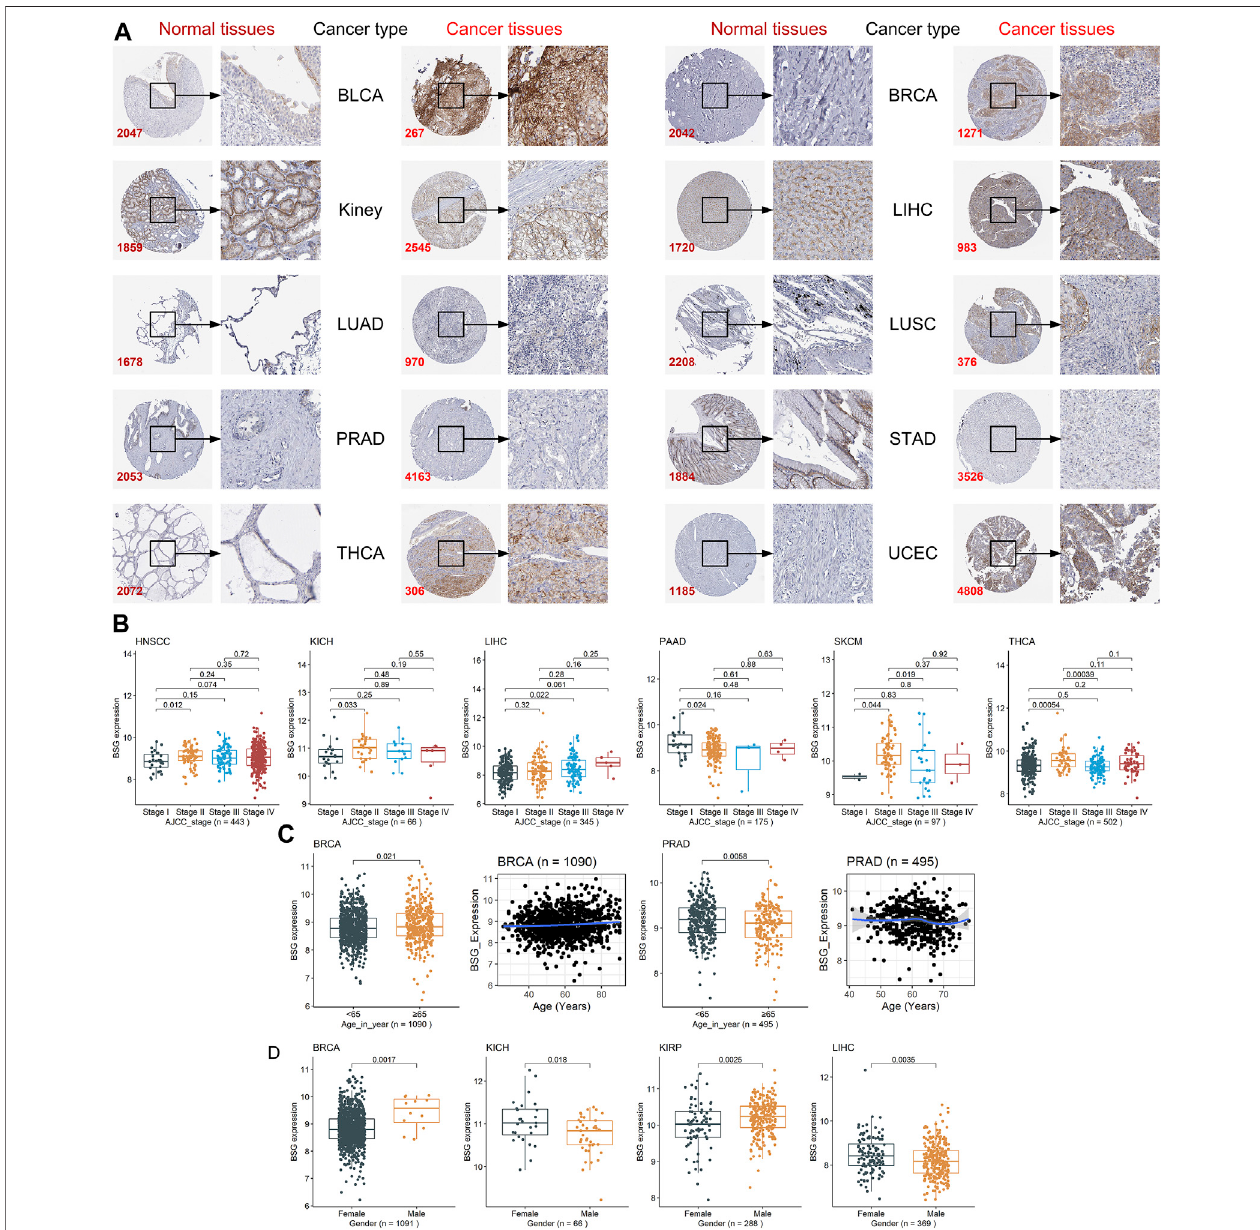
FIGURE 3 | Staining intensity of the anti-BSG antibodies in the ten cancers and the correlations between BSG expression and clinical parameters. (A) Under the microscope, the staining intensity of the anti-BSG antibodies in the ten cancer tissues is observed to be stronger than that in normal tissues; images are available from v21.0.proteinatlas.org. In (A) ,thevalueofthelower-leftcorner oftheimages(e.g.,2047forBLCA) istheidentitydocumentofpatientsornormalindividuals. (B – D) Close correlations between BSG expression with clinical parameters; all p -values in the three panels are based on the Wilcoxon rank-sum test. The two plots with a blue curve of panel (C) are drawn based on the locally weighted regression. The value in parentheses (e.g., “ n = 443 ” for HNSCC) represents the number of samples. BLCA, bladder cancer; BRCA, invasive breast carcinoma; LIHC, liver hepatocellular carcinoma; LUAD, lung adenocarcinoma; LUSC, lung squamous cell carcinoma; PRAD, prostate adenocarcinoma; STAD, stomach adenocarcinoma; THCA, thyroid carcinoma; UCEC, uterine corpus endometrial carcinoma; HNSCC, head and neck squamous cell carcinoma; KICH, kidney chromophobe; PAAD, pancreatic adenocarcinoma; SKCM, skin cutaneous melanoma.